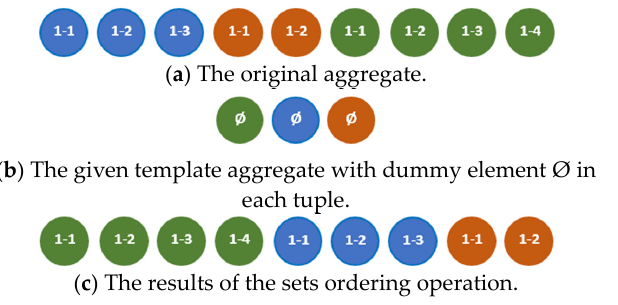
Figure 15. An example of applying the symmetric di ff erence operation to two incompatible aggre- gates.